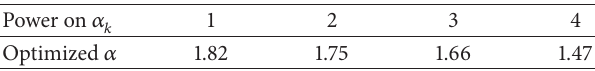
Table 5: The impact of the functional form of FOC 𝑘 . Power on 𝛼 𝑘